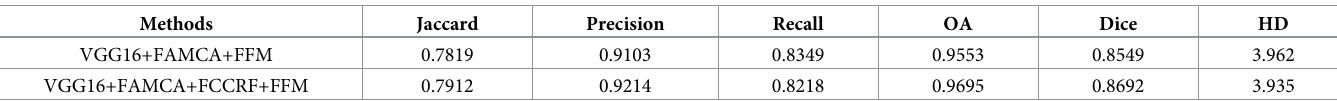
Table 4. Ablation study for FCCRF module.